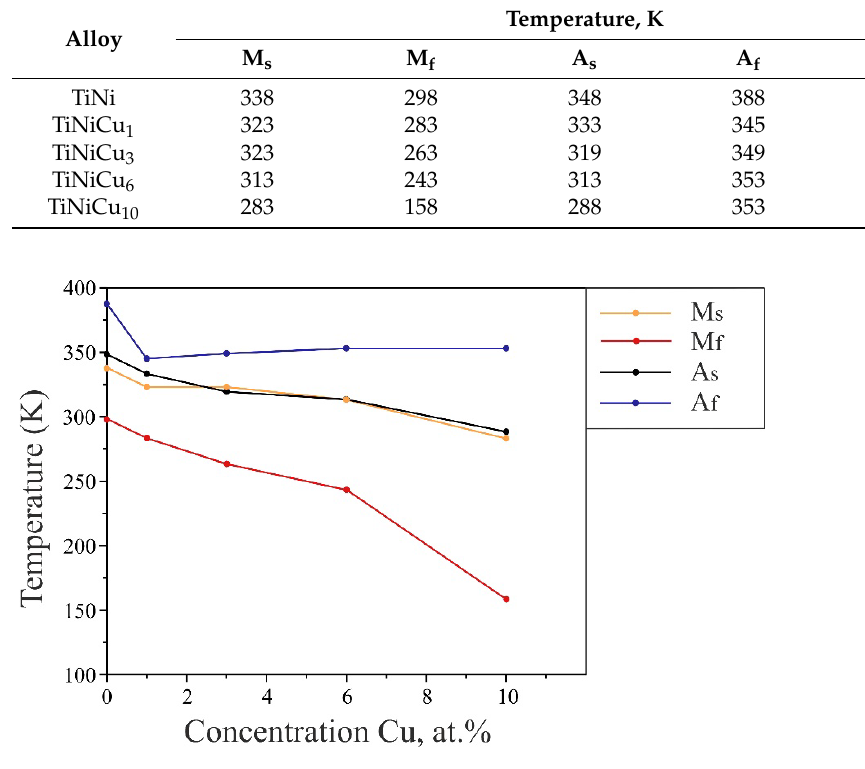
Figure 5. Concentration dependence of the characteristic temperatures of martensitic transfor- mations for materials TiNi-Cu. for materials